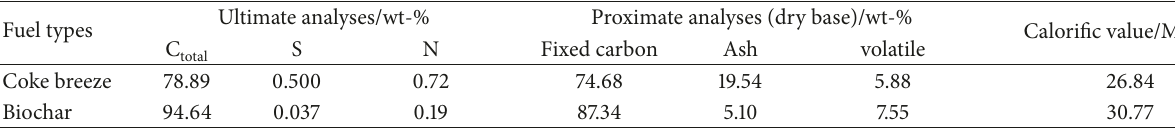
Table 2: Ultimate and proximate analyses of solid fuels.